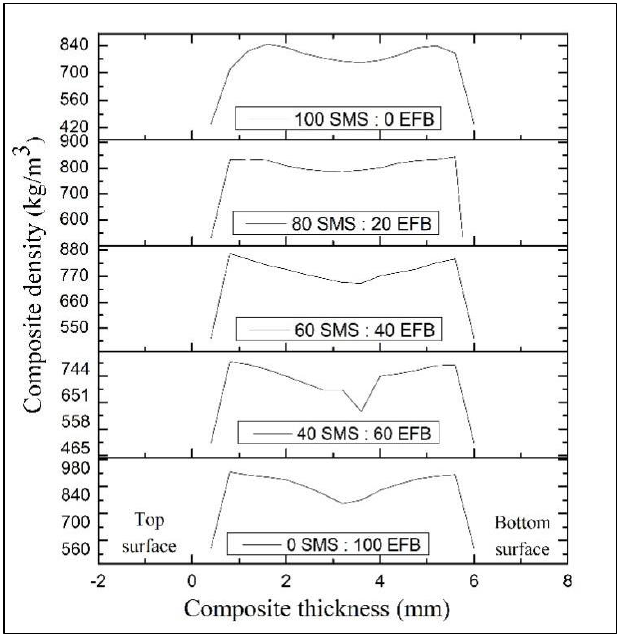
Figure 8. Density profile of the sandwich composite panel at different fiber ratios.